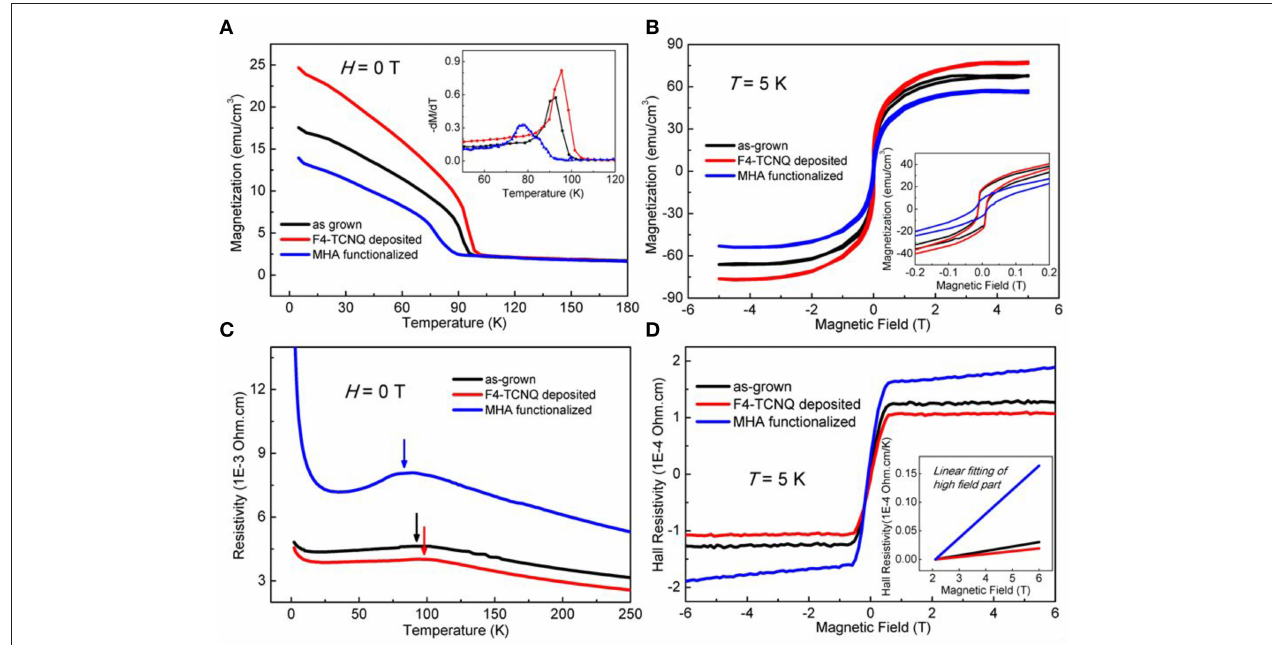
FIGURE 2 | Molecular modifications of ferromagnetism in a 9 nm thick (Ga,Mn)As film capped with 1 nm GaAs [54]. (A) Temperature dependence of the remnant magnetization M ( T ). Inset: temperature derivative of the remnant magnetization d M /d T vs. temperature curves, showing more clearly the modulation of T C for the three films. (B) Magnetization hysteresis loops measured at 5 K for the same three films. Inset: magnification of the low field region. (C) Temperature dependence of the longitudinal resistivity. (D) Hall resistivity for the same three films measured at 5 K. Inset: Linear fittings of the high field data, indicating a clear change of the hole